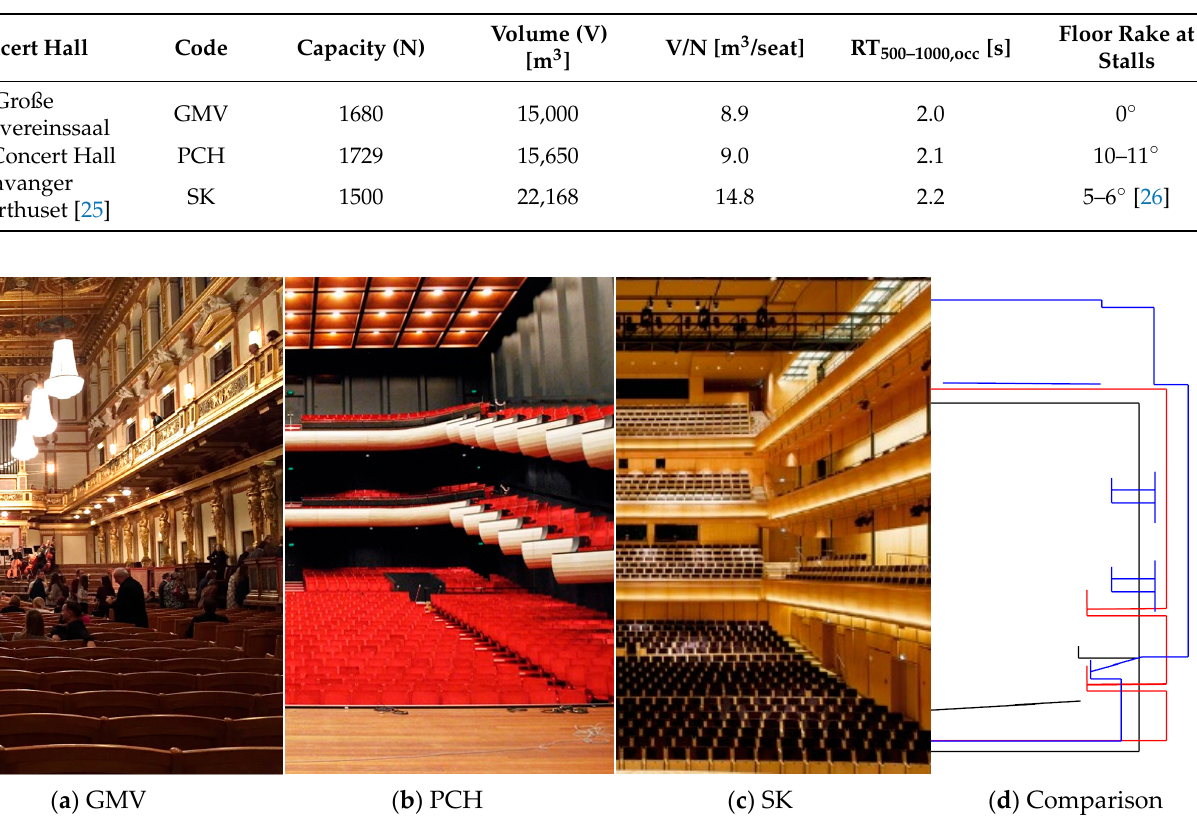
Table 1. Data for selected concert halls.